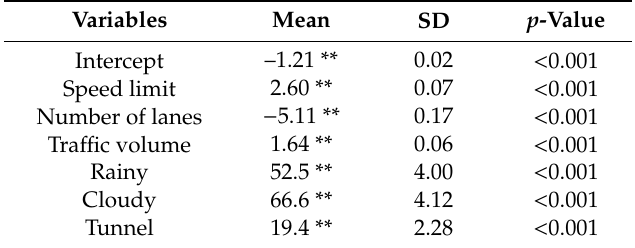
Table 4. Elasticity analyses results for the two-level binary logistic